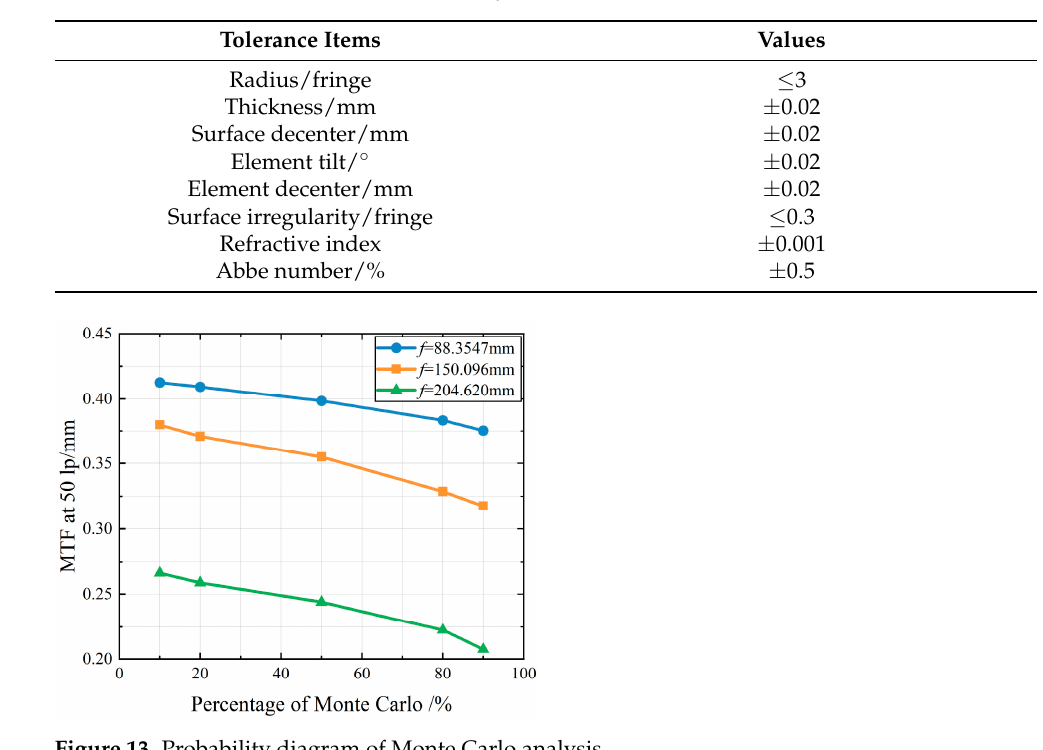
Figure 13. Probability diagram of Monte Carlo